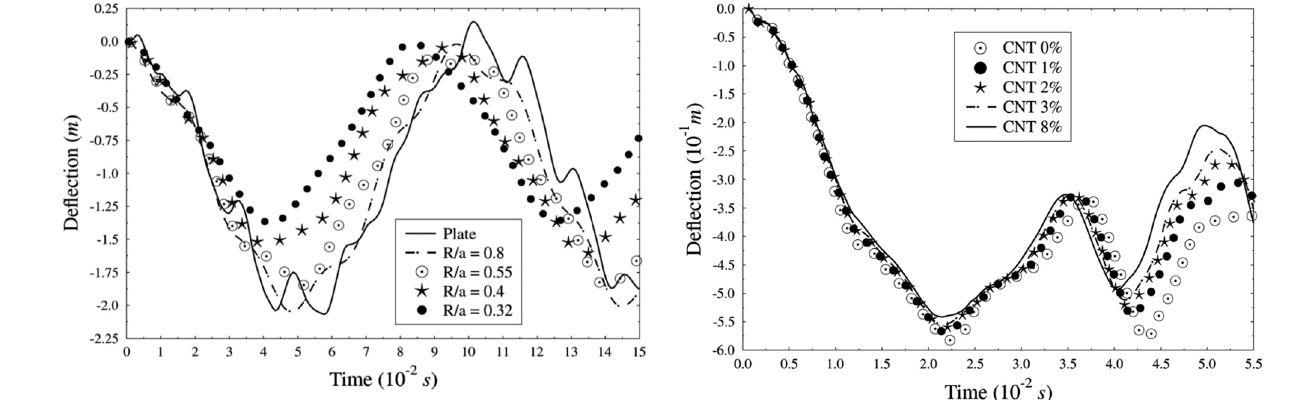
Figure 12: Nonlinear dynamic time histories of CNTFPC cylindrical panels for di ff erent SWCNT weight ratios.